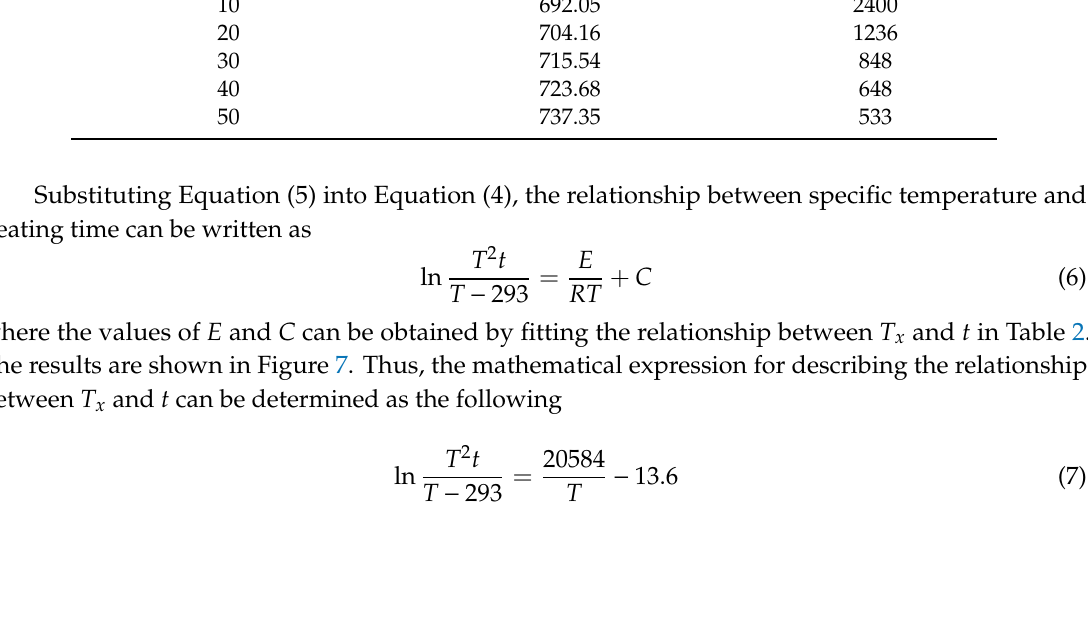
Table 2. The crystallization temperature and heating time of Zr-based BMGs at different heating rates. Crystallization Temperature in Heating Rate ( B / (K / min)) during Heating Process ( T x / ( B/ (K/min))